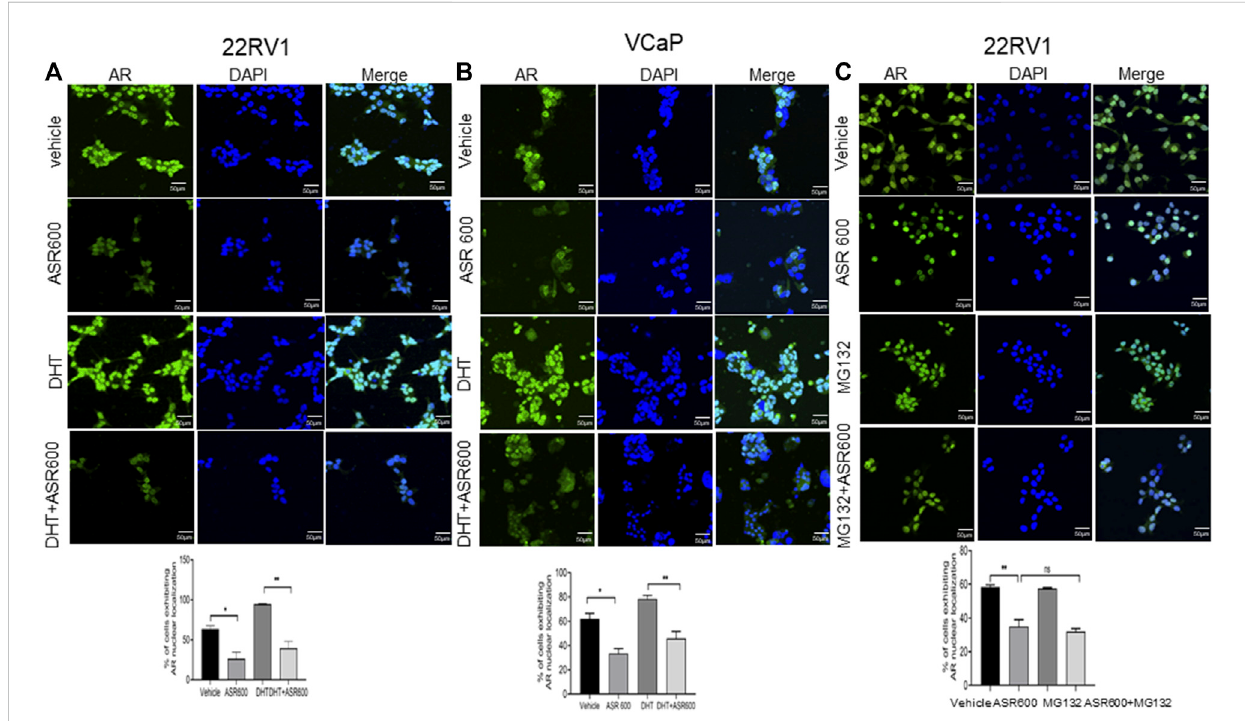
FIGURE 3 Nuclear accumulation of AR abolished by ASR-600. (A, B) . Immuno fl uorescence analysis of cyto-nuclear localization of AR expression in ASR-600, DHT, or ASR 600 + DHT treated 22RV1 and VCaP cells. (C) . Immuno fl uorescence analysis of cyto-nuclear localization of AR expression in